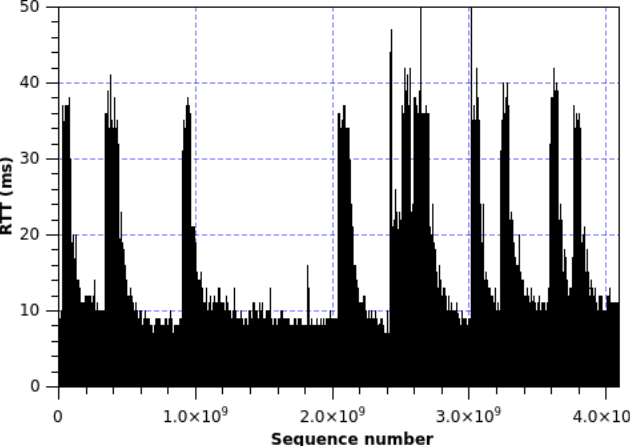
Figure 14. TCP session RTT on router with a modified Linux kernel.